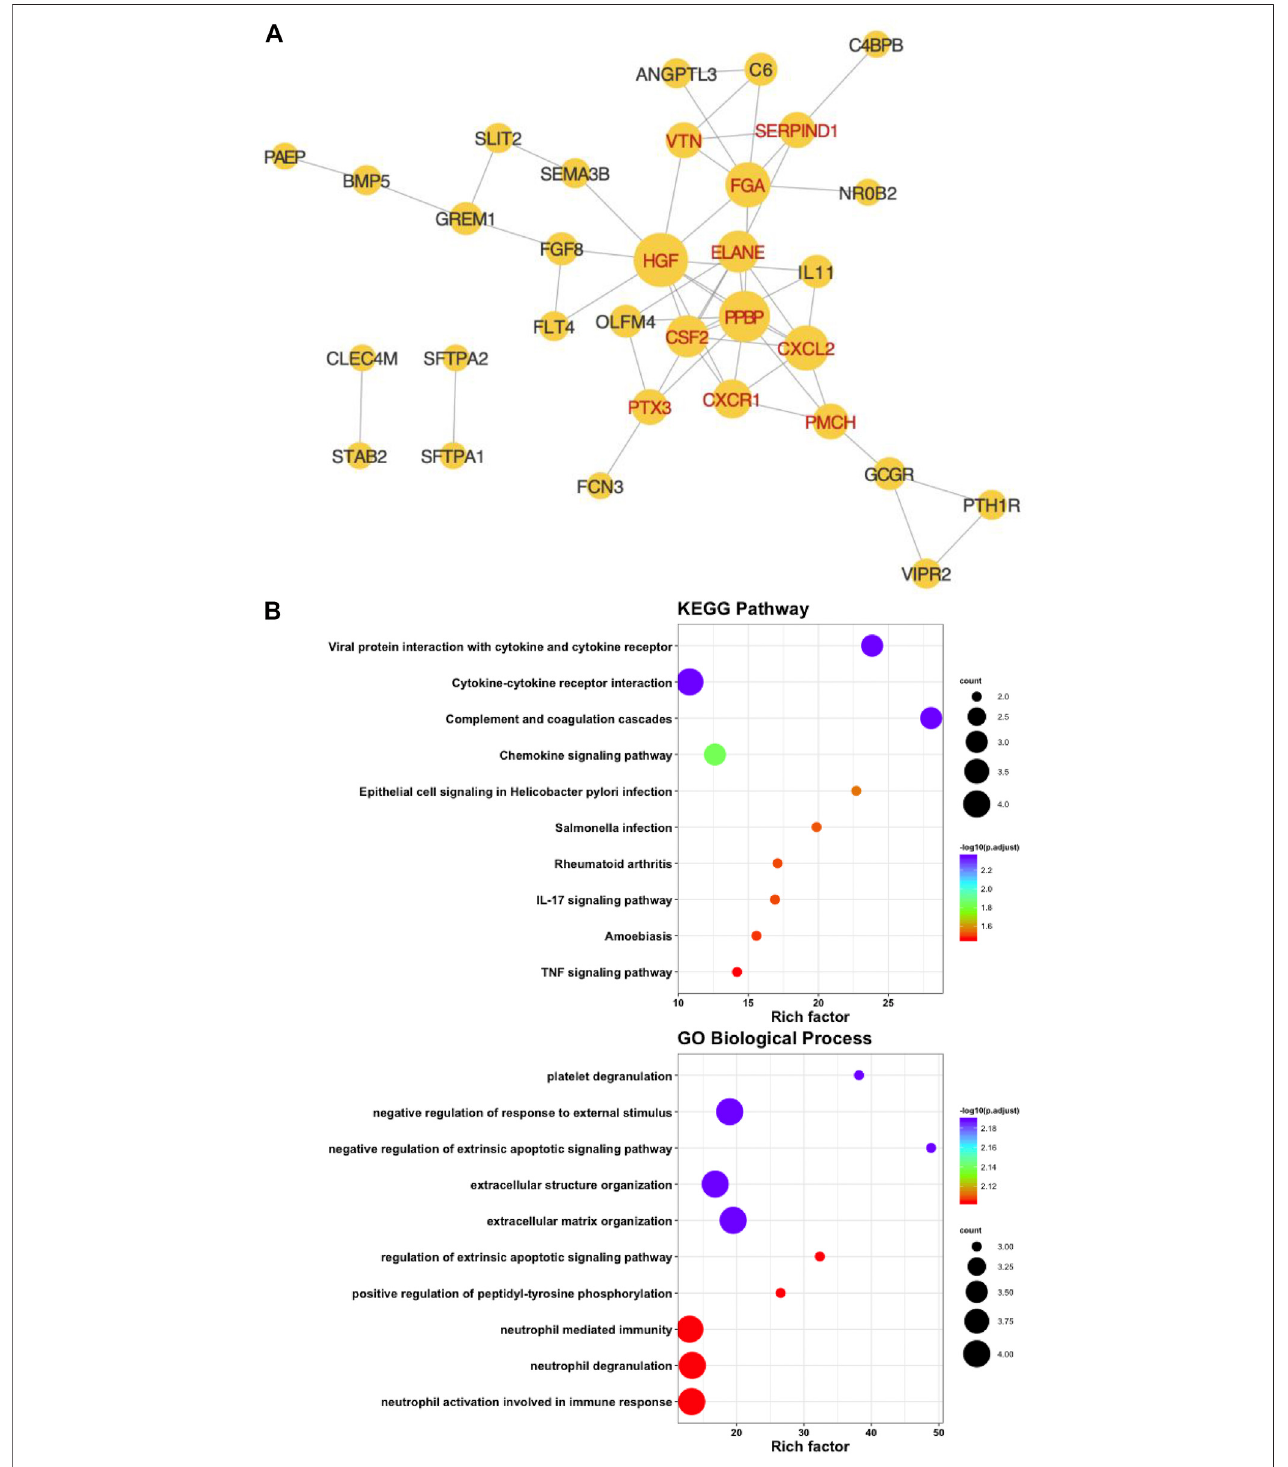
FIGURE 4 | Identi fi cation of hub immune-associated genes. (A) Protein-protein interaction network of hub IRGs. (B) Kyoto Encyclopedia of Genes and GO Biological Process analysis of hub IRGs.